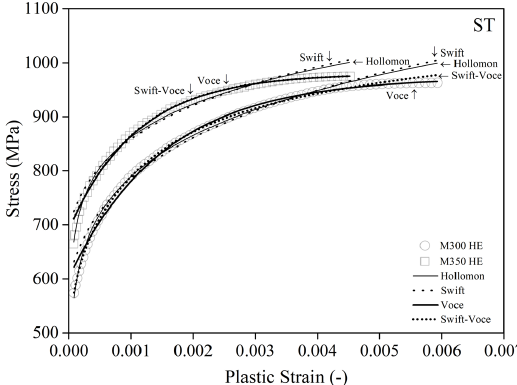
Figure 7. Curve fitting approach using different models for ST maraging steels by HE environment.